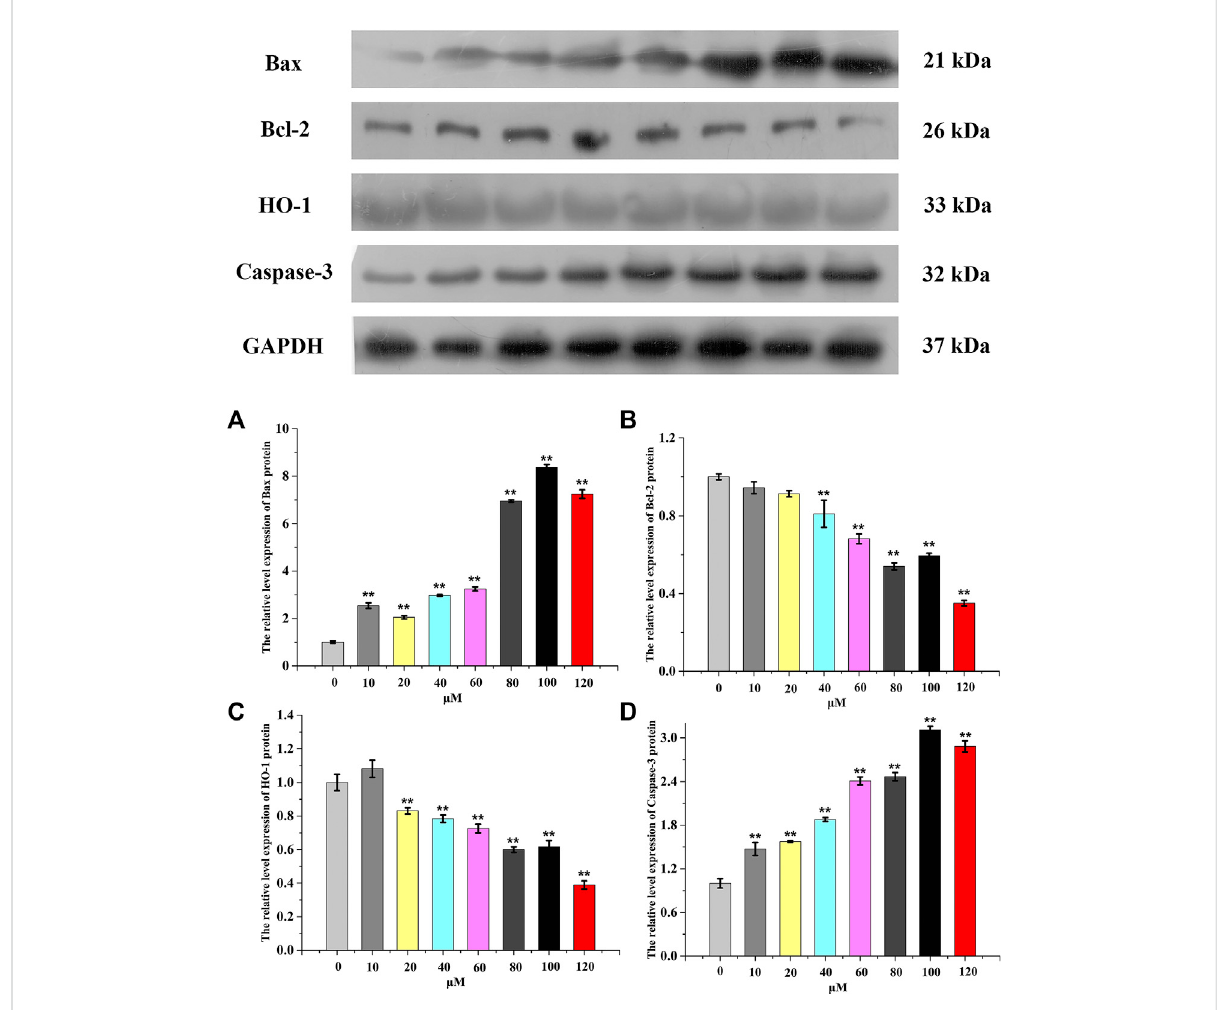
FIGURE 7 ChangesinBax (A) ,Bcl-2 (B) ,HO-1 (C) andCaspase-3 (D) cellexpressiontreatedwithcomplex5againstHepG2cellsfor24 h.GAPDHwasused as the loading control. Data are presented as the mean ± SEM. *: p < 0.05, **: p < 0.01. Each concentration compared to the